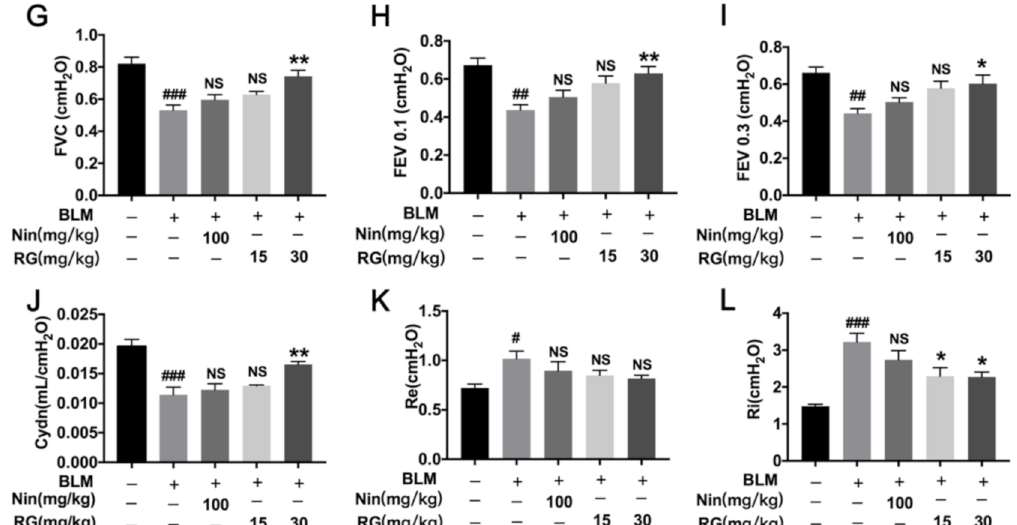
Figure 1. Regorafenib attenuated bleomycin (BLM)-induced pulmonary fibrosis in mice. ( A ) Regorafenib (15 mg/kg, 30 mg/kg) and nintedanib (100 mg/kg) were given orally once a day from days 7–13 after BLM treatment, lungs were harvested at day 14, and body weight loss was measured every day; ( B ) Percentages of surviving mice were plotted from days 7–14 after bleomycin treatment; ( C ) Representative images of hematoxylin–eosin (H&E) and Masson staining of lung tissue sections. Scale bars: 50 µ M; ( D ) Percentages of fibrotic area in lung tissues; ( E ) Hydroxyproline contents in right lung tissues; ( F ) Immunohistochemistry of lung sections was used to analyze the expression levels of α -smooth muscle actin ( α -SMA), collagen 1 (Col 1), and fibronectin (Fn). Quantitative analysis is shown below. Scale bars: 50 µ m; ( G – L ) Pulmonary function parameters, such as forced vital capacity (FVC), forced expiratory volume in 0.1 s (FEV0.1), forced expiratory volume in 0.3 s (FEV0.3), expiratory resistance (Re), inspiratory resistance (Ri), and dynamic compliance (Cydn). Data in ( A , B ) and ( D – L ) are means ± standard error of mean (SEM), n = 6; # p < 0.05, ## p < 0.01, ### p < 0.001, * p < 0.05, ** p < 0.01, *** p < 0.001 (one-way ANOVA), NS: not